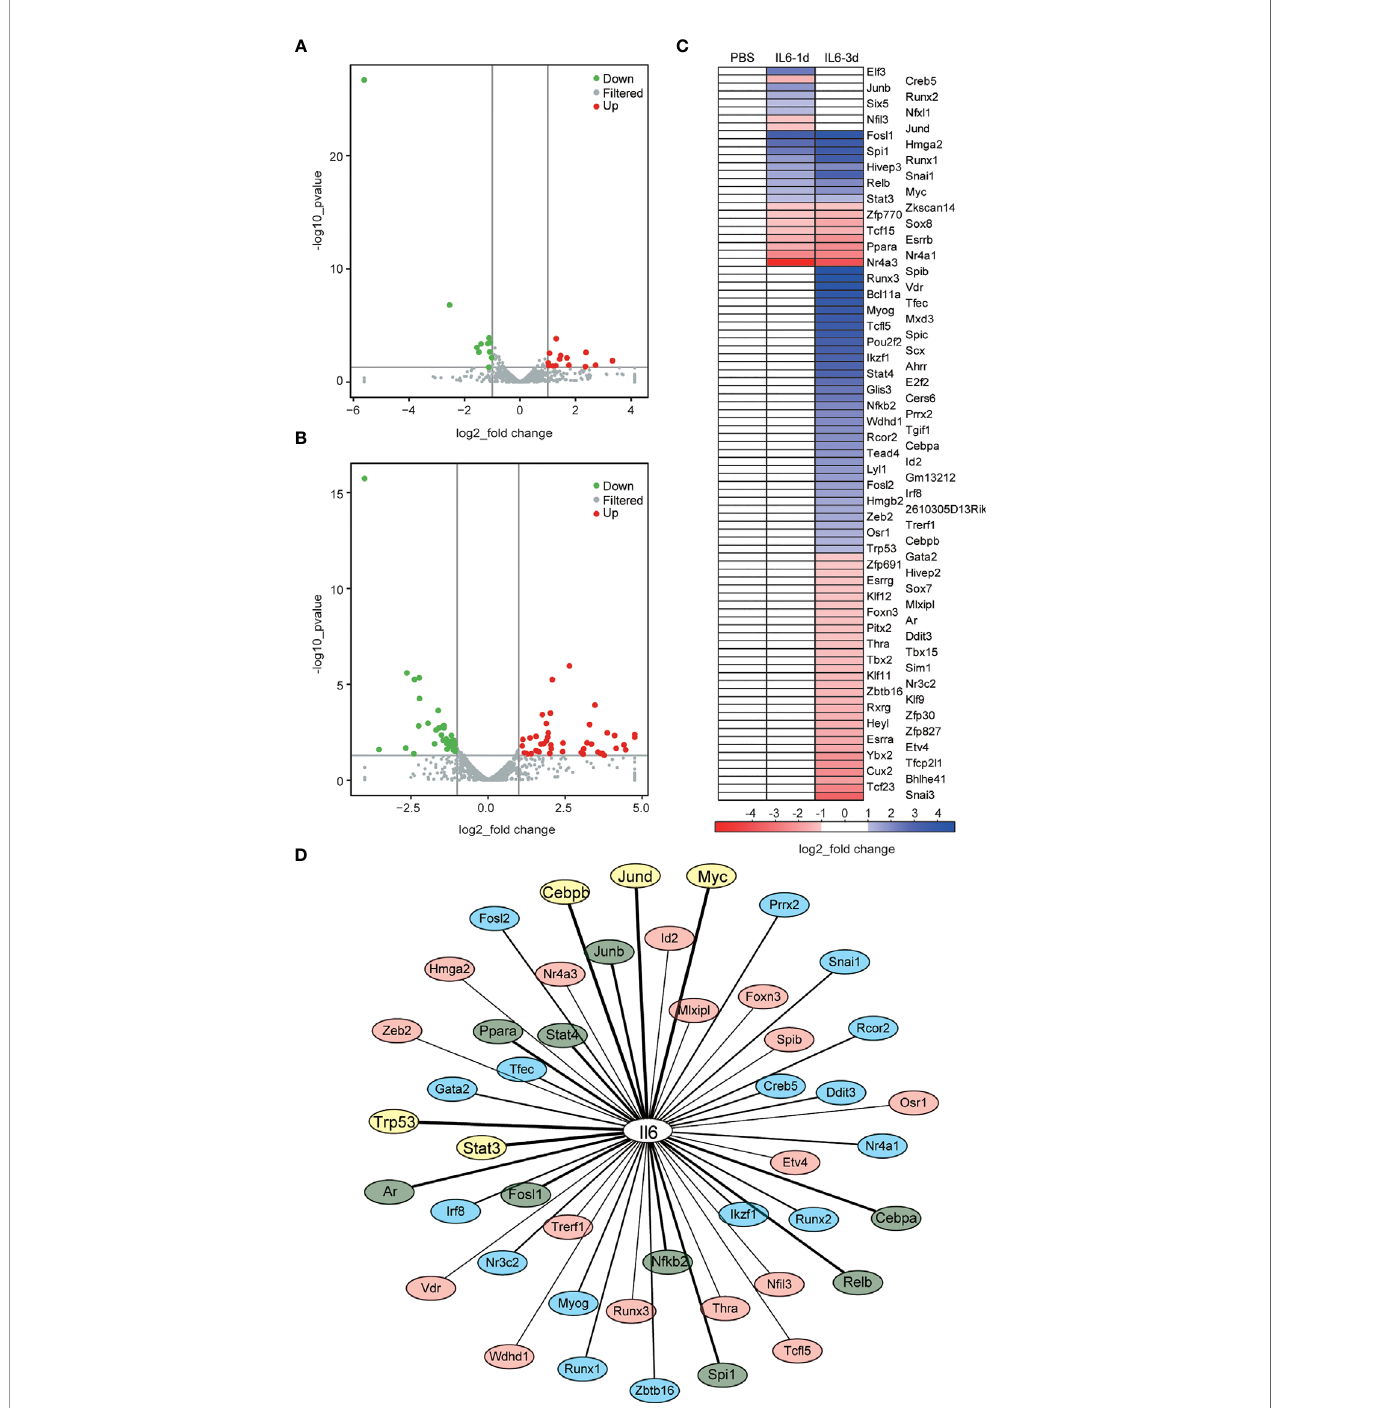
FIGURE 6 | Identi fi cation of differentially expressed transcription factors (DETFs) and interaction between interleukin-6 (IL-6) and transcription factors (TFs). (A, B) Volcano graphs representing the DETFs after one day (A) and three days (B) of IL-6 infusion. Red indicates up-regulated expression, and green indicates down-regulated expression. (C) Heat map of the DETFs, which are classi fi ed according to their differential expression after one day of IL-6 infusion, their co-differential expression after one and three days of IL-6 infusion, and their differential expression after three days of IL-6 infusion. Blue indicates up-regulated expression, and green indicates down-regulated expression. (D) Interaction analysis between IL-6 and DETFs. Interaction between IL-6 and DETFs is ranked from strong to weak: TFs with a score > 800 are marked in yellow, 800 > score > 500 marked in green, 500 > score > 300 marked in blue, and a score < 300 marked in light red. down, down-regulated; up, up-regulated; IL-6, interleukin-6; PBS, phosphate-buffered saline; TF, transcription